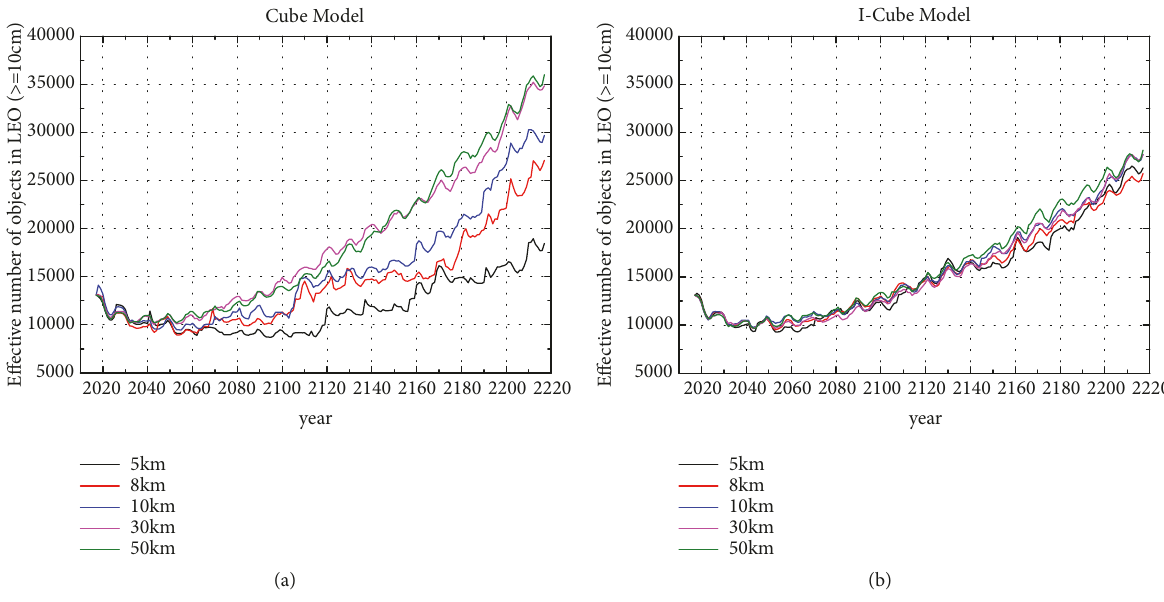
Figure 4: Comparison of simulation results with different cube size. (a) Using CUBE model. (b) Using I-CUBE model.